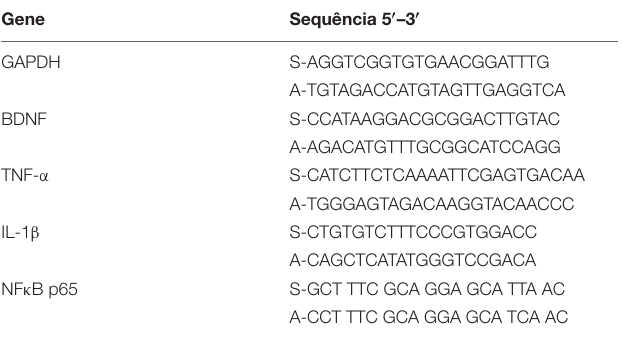
TABLE 1 | Primers’ sequences.